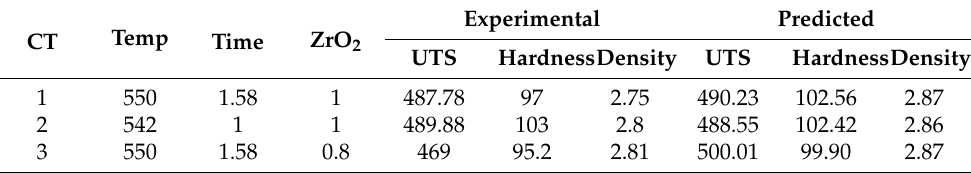
Figure 14. UTS, microhardness and density optimal plot. Table 9. The confirmation test results.